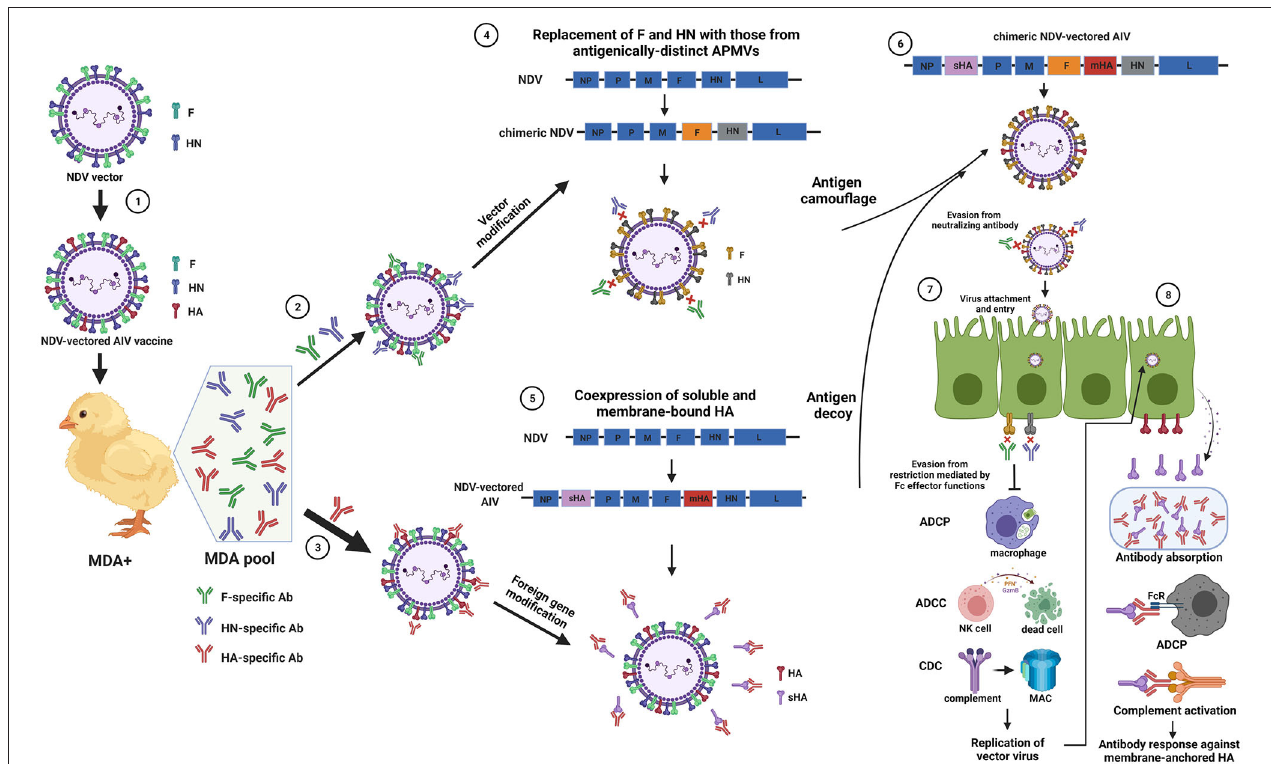
FIGURE 1 | Schematic illustration of the “antigen camouflage” and “antigen decoy” combination in Newcastle disease virus vector to circumvent or overcome MDA interference. The hemagglutinin (HA) protein of influenza virus was shown as an example of the gene of interest. 1 The traditional strategy of generating a recombinant NDV expressing the HA protein in a membrane-bound form. 2 Maternally-derived antibody (MDA) against NDV binds the fusion (F) and hemagglutinin-neuraminidase (HN) proteins and interferes with antibody response. 3 HA-specific MDA binds the HA protein on virus surface and inhibits specific antibody immunity. A wider arrow (compared to 2 ) was used to indicate a stronger interference from the HA-MDA than NDV-MDA. 4 The “antigen camouflage” strategy with the F and HN genes in NDV replaced with those from antigenically-distant avian paramyxovirus viruses (APMVs). This modification results in evasion of the vectored vaccines from binding of NDV-MDA. Usage of entire APMVs as the vector can also achieve this purpose. 5 The “antigen decoy” strategy with co-expression of soluble and membrane-bound HA in NDV vector. This modification leads to production of soluble HA in the extracellular space, acting as a HA-MDA absorber and immunomodulator. sHA, soluble HA; mHA, membrane-bound HA. 6 Co-expression of both sHA and mHA in the chimeric NDV vector, combining the “antigen camouflage” and “antigen decoy” strategies together. 7 The resultant vaccine cannot be recognized by preexisting NDV antibodies, resulting in evasion from neutralization and antibody-dependent restriction effect, including antibody-dependent cellular phagocytosis (ADCP), antibody-dependent cell-mediated cytotoxicity (ADCC) and complement-dependent cytotoxicity (CDC). This allows efficient replication of vaccine in NDV-MDA chickens. NK cell, natural killer cells; PFN, perforin; GzmB, granzyme; MAC, membrane attack complex. 8 Replication of the vaccine in the cells (e.g. respiratory tract epithelial cells) produces both the mHA and sHA. The sHA may absorb a proportion of preexisting HA-specific antibodies and modulate Fc-mediated effector functions to stimulate antibody response against the mHA. The illustration was created with BioRender.com.